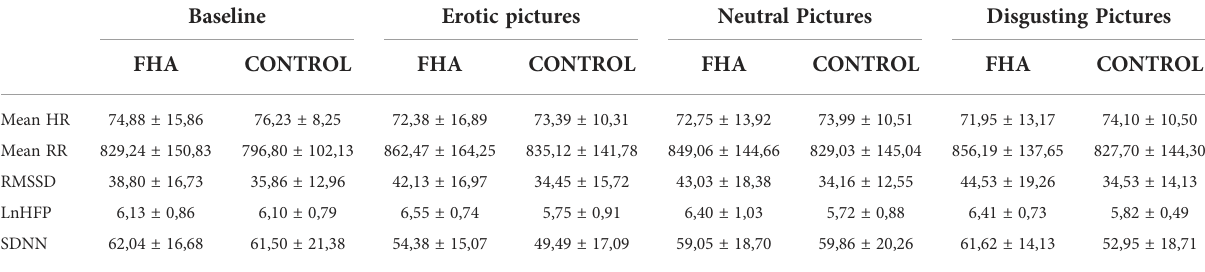
TABLE 2 Cardiological data in Functional Hypothalamic Amenorrhea group (FHA) and control group (control) for each picture block.